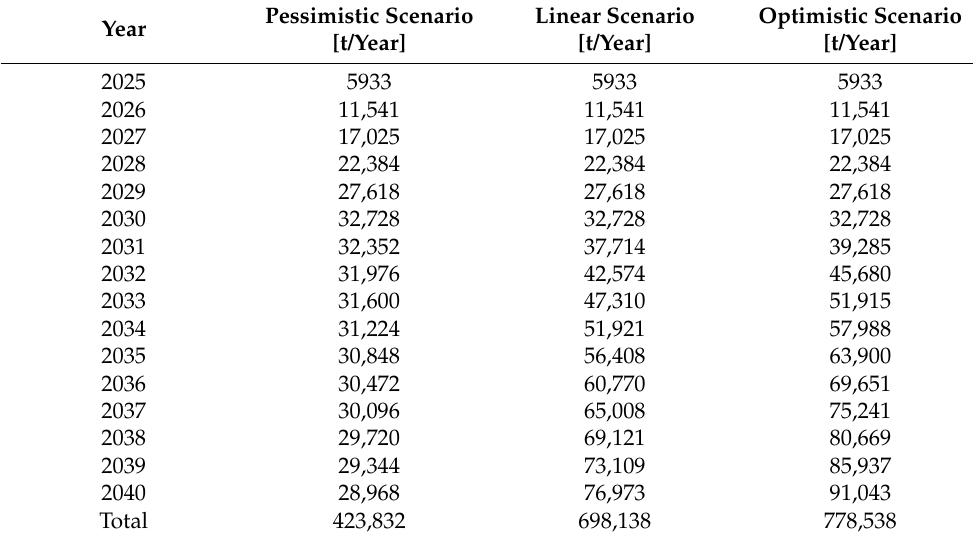
Table 8. Total CO 2 emission reduction, w.r.t. no-FCEV scenario [4].